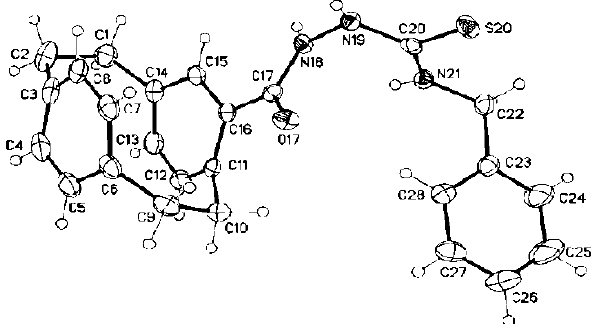
Figure 5. Molecular structure of compound 2b identified according to IUPAC nomenclature as 2-